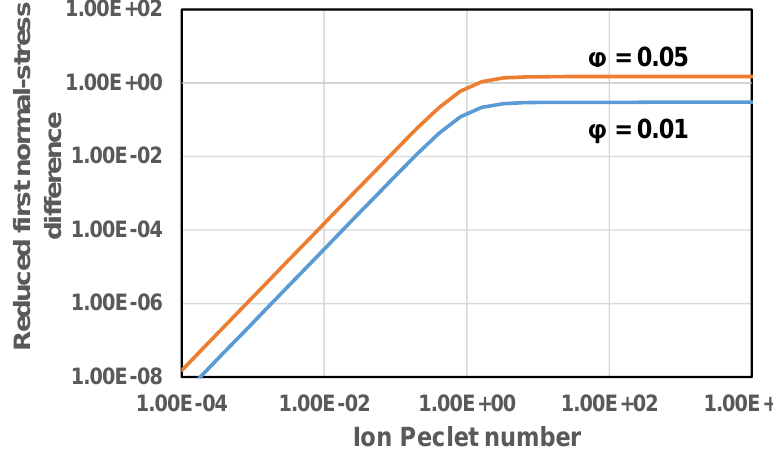
  22 (cid:0) (cid:1) 01 RN  as a function of ion Peclet number. ε ψ 2 / R 2 as a function of ion Peclet number.   22 0 01 RN  as a function of ion Peclet number.